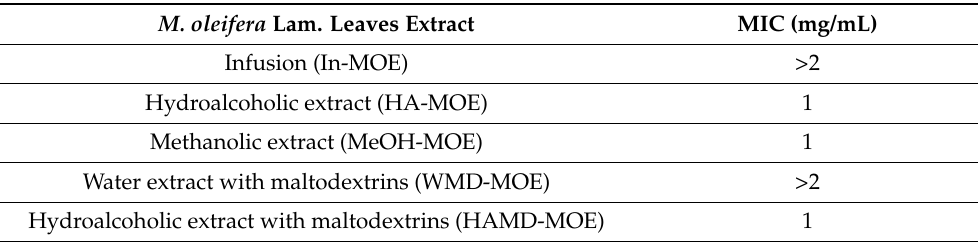
Table 1. MIC values: Each value was obtained from three different experiments performed on triplicate (mean +/ − standard deviation). No significant difference was observed for each EA strain; reason why the results are presented with one value for all